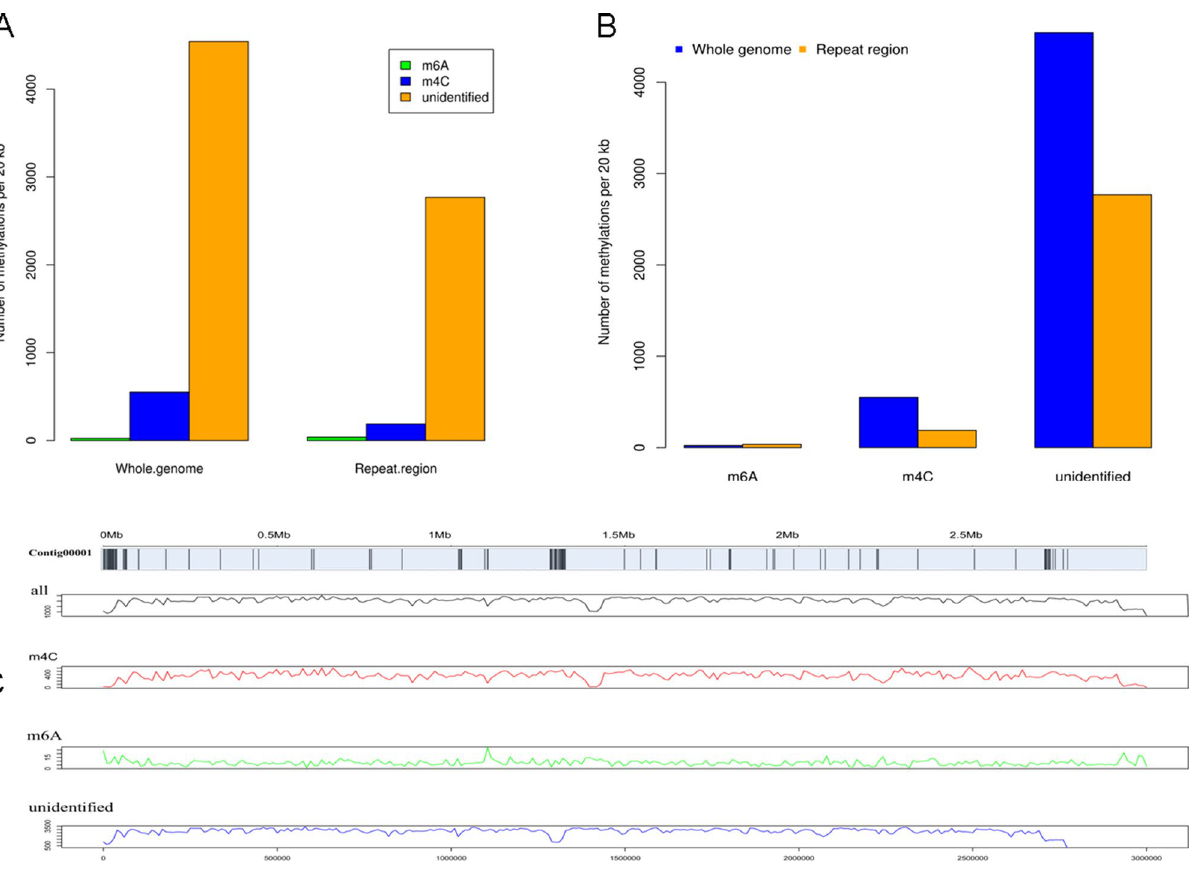
Figure 3. DNA methylation analysis of Sc. genomic. ( A ) The distribution of repeat sequences in the scaffold and different DNA methylation types. The histogram represents the distribution of repeating elements. All data were analyzed to produce the statistical result indicated within the 20-kb window. ( B ) Calculation of the number of different types of methylation per 20 kb across the entire Sc. genome. ( C ) Distribution of repeating